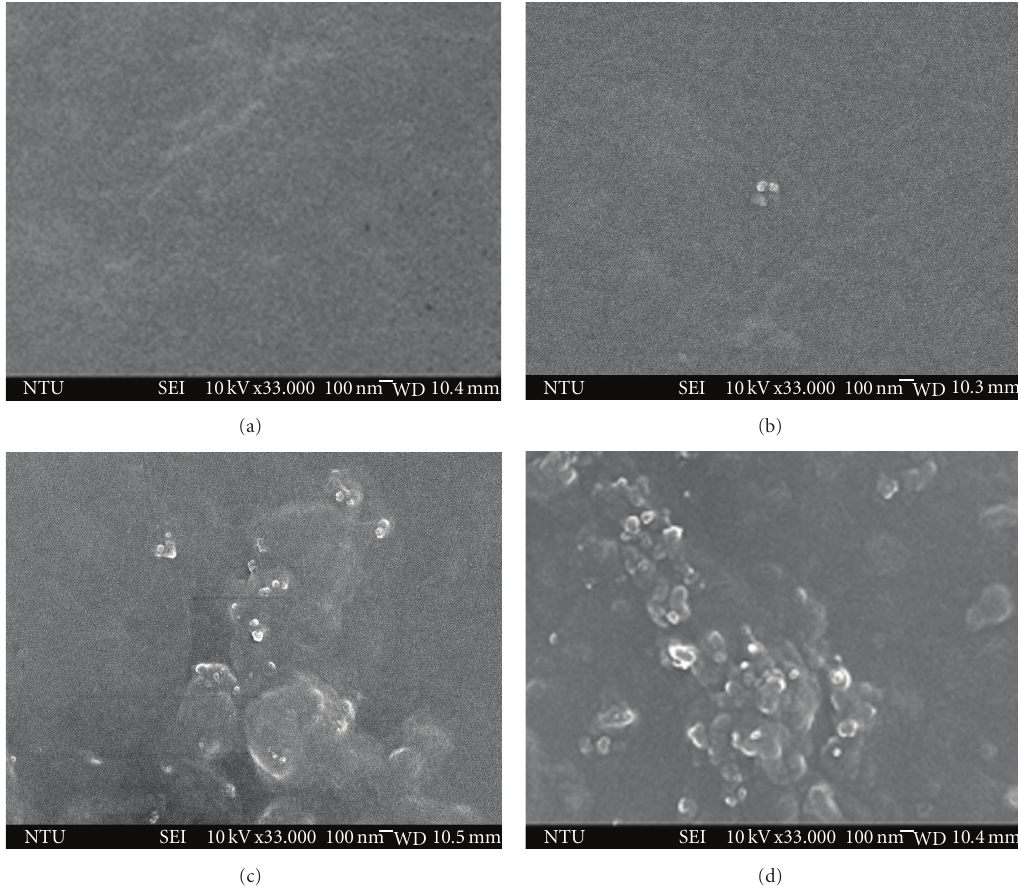
Figure 4: The SEM image for various concentration of CNP/P3HT blending solution (a) pristine P3HT; (b) CNP/P3HT = 0.1 wt.%; (c)